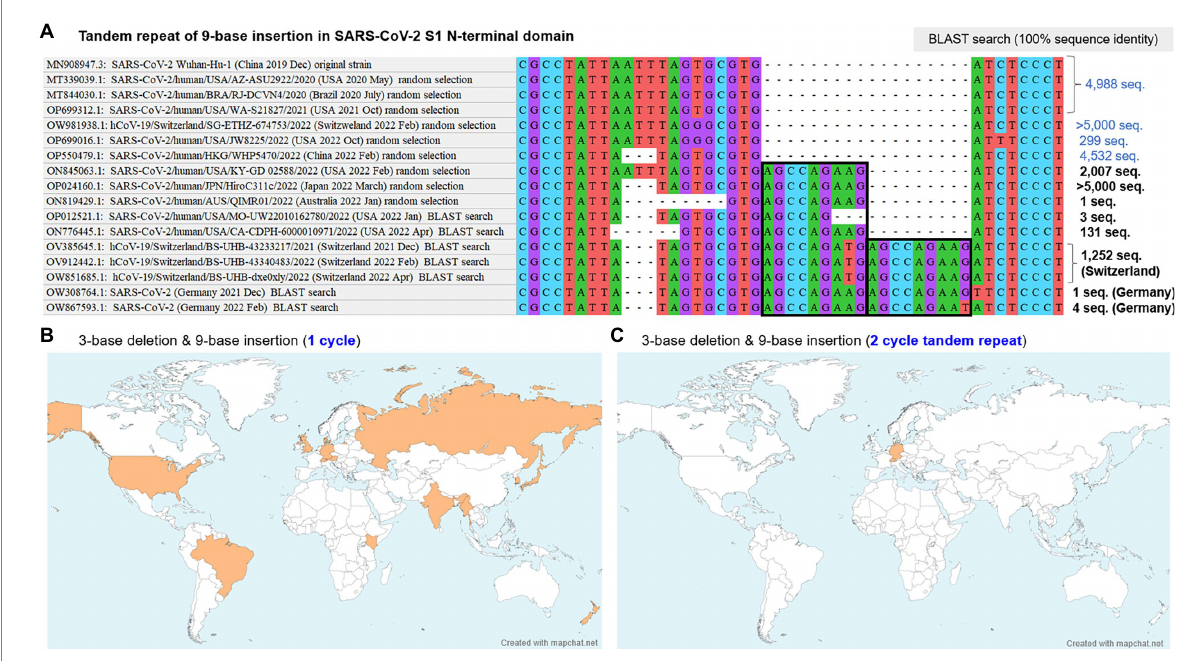
FIGURE 2 BLAST search results and geographic distribution of two-cycle tandem repeat of the 9-base insertion. (A) The aligned sequences at the identified polymorphic indel hotspot in SARS-CoV-2 S1-NTD are shown, together with the numbers of identified sequences with 100% sequence identity for each sequence based on the NCBI BLAST search. Both of the one-cycle and two-cycle tandem repeat of the 9-base insertion were dated from the November 2021 in Switzerland. The two-cycle tandem repeat did not spread across the globe, whereas the one-cycle 9-base insertion rapidly spread across the globe in 2022, estimated to account for 20–50% of the overall SARS-CoV-2 sampled from humans in 2022. (B,C) Geographic distributions of the one-cycle and two-cycles of the 9-base insertion with the nearby 3-base deletion. Although both cycles were suggested to originate in November 2021 in central Europe, the former rapidly spread across the globe, whereas the latter was limited in Switzerland. BLAST, basic local alignment search tool; S1-NTD, N-terminal domain of S1 gene; SARS-CoV-2, severe acute respiratory syndrome coronavirus